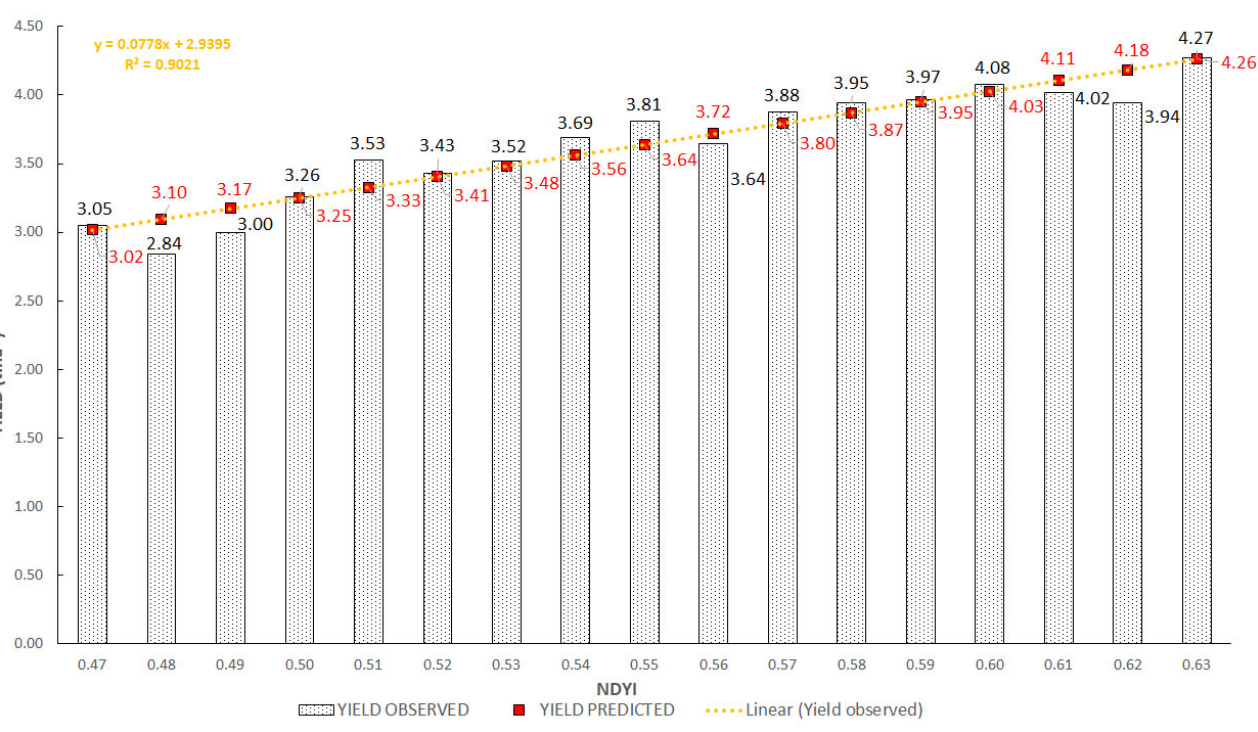
Figure 13. Graph of linear dependence of yield on NDYI. Model shows yields observed and yields predicted based on the regression analysis of NDYI and yields achieved.